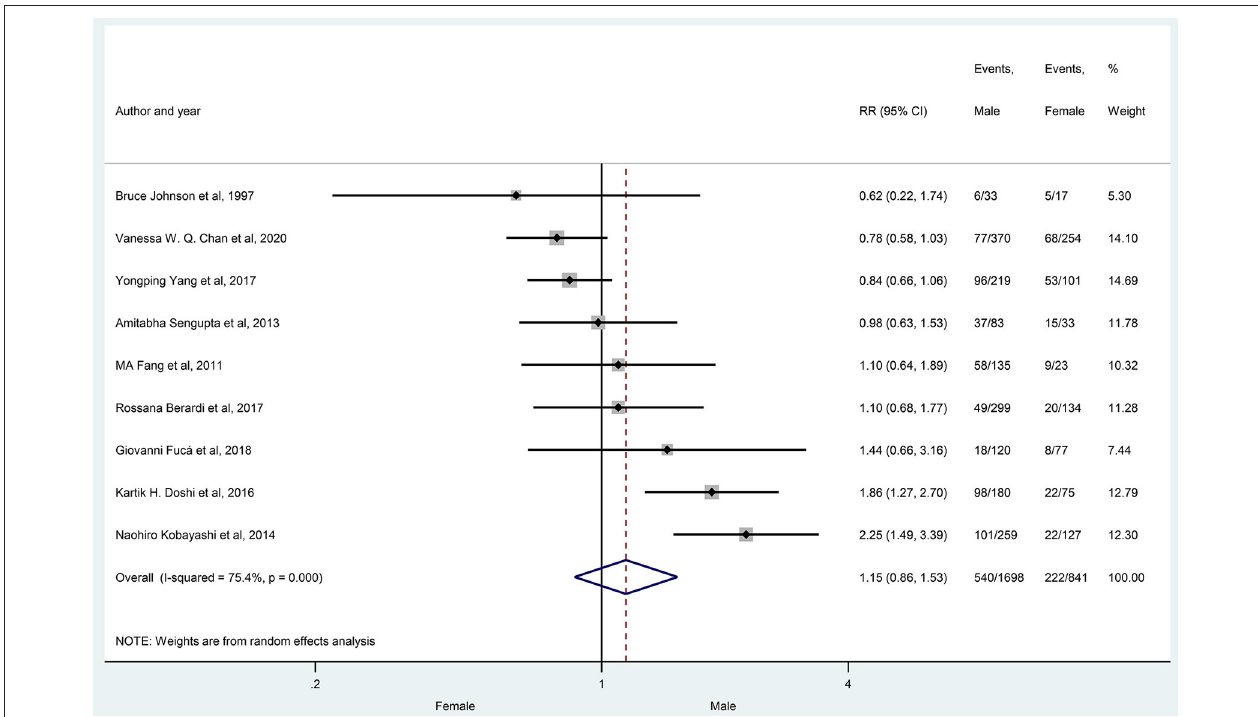
FIGURE 3 | The prevalence of hyponatremia in male and female patients with lung cancer. Black diamonds represent the individual effects of studies, and vertical lines show the corresponding 95% CI. The size of the gray squares reflects the individual weight of a particular study. The blue diamond shows the overall or summary effect. The outer edges of the diamonds represent the CIs. RR, risk ratio.